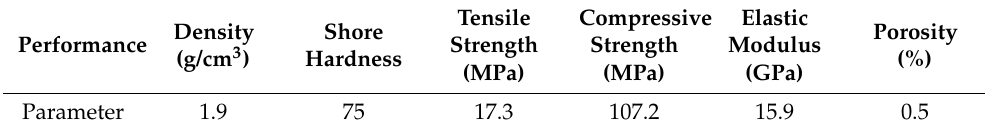
Figure 1. Orthogonal cutting experiment device: ( a ) clamping method and ( b ) dynamometer. Table 1. Mechanical properties of graphite/polymer composites.